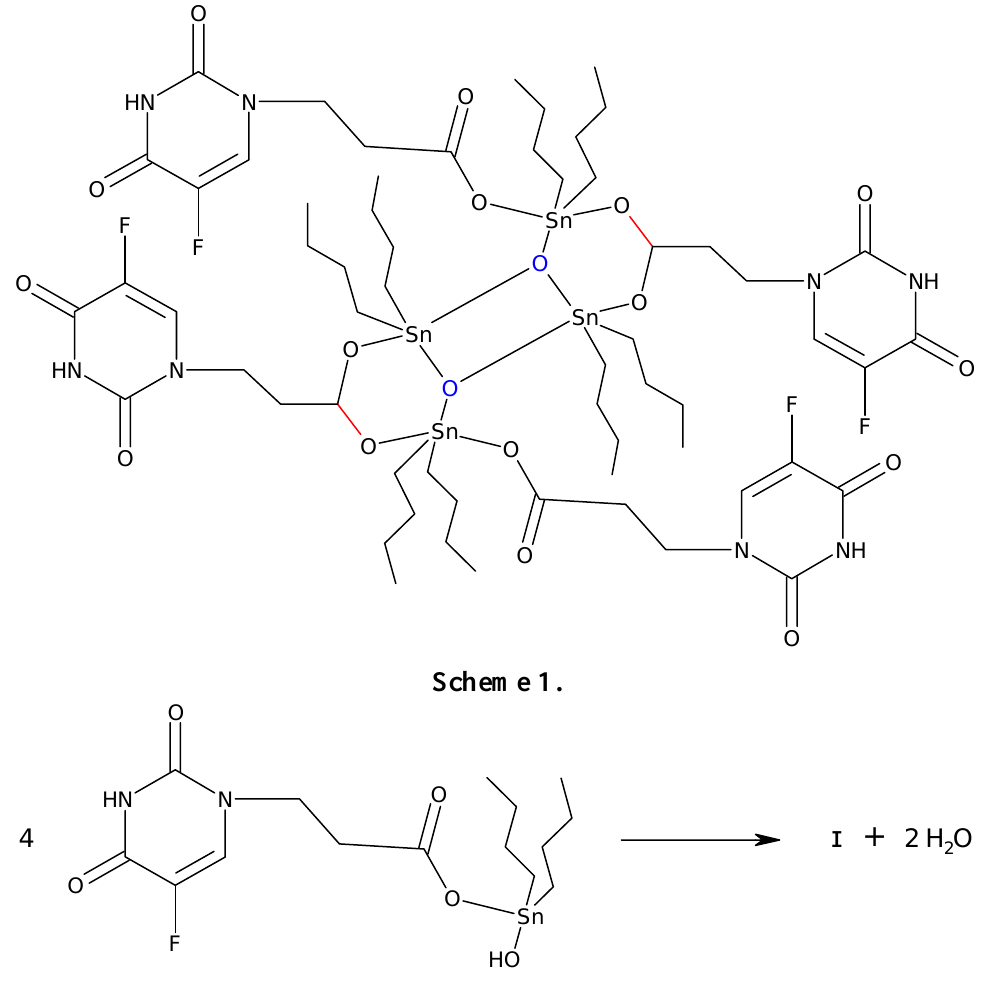
Figure 1. Structure I as drawn in the original paper